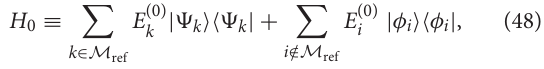
FIGURE 5 | Ground-state binding energies per particle (A) and correlation energy per particle (B) of closed-shell nuclei from second-order MBPT ( MBPT ( l ), CCSD ( △ ), and CR-CC(2,3) ( H ) using the Hamiltonian described in section 3. All calculations are performed using 13 oscillator shells and an oscillator frequency of ¯ h ω = 20MeV. The SRG parameter is set to α = 0.08fm 4 . Reproduced from Tichai et al. [34] under the Creative Commons CC-BY